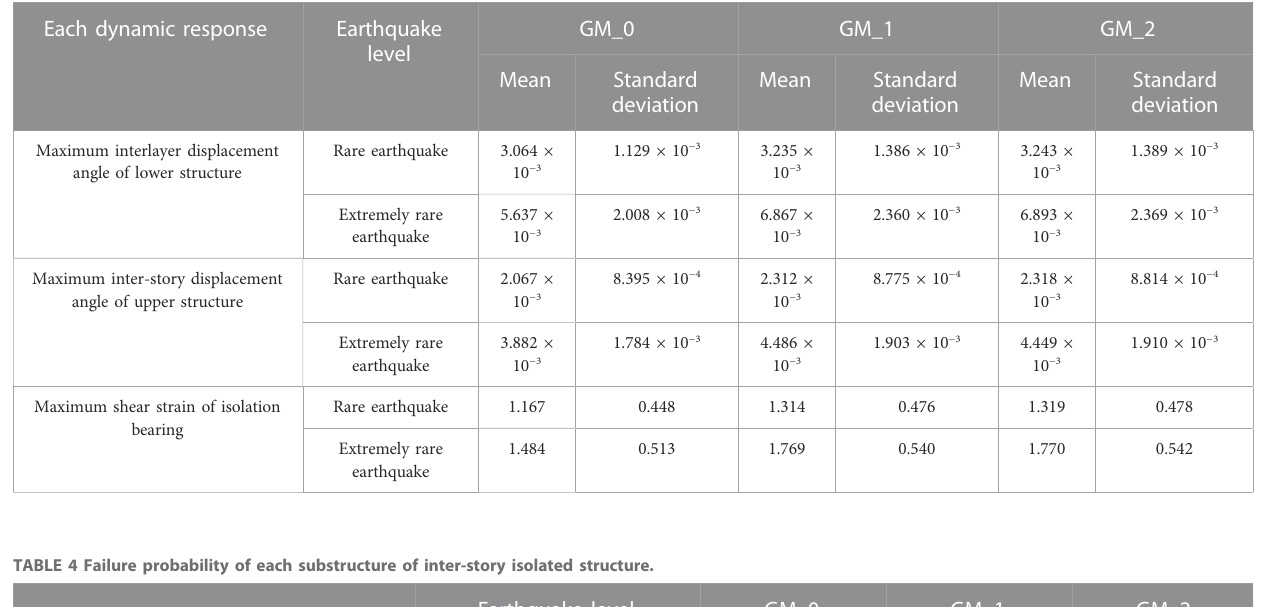
TABLE 3 Probabilistic characteristic parameters of structural response values.